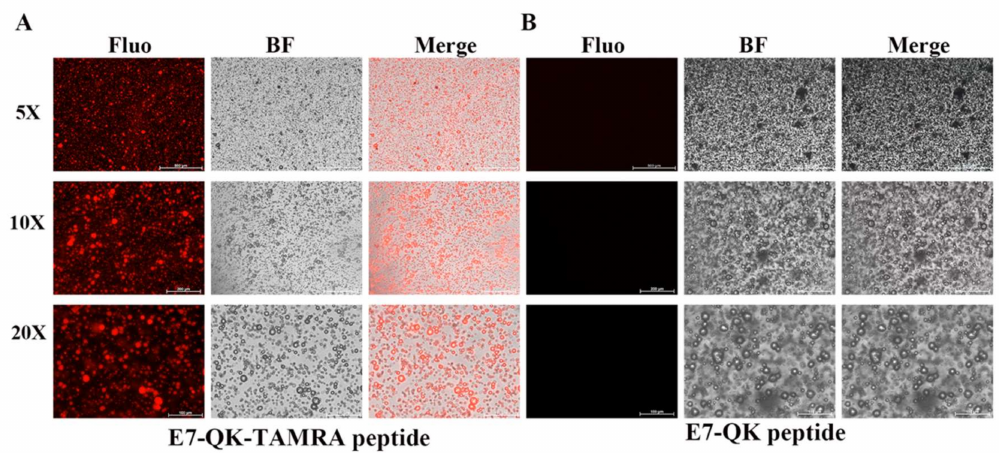
Figure 6. Detection of E7-QK and E7-QK-TAMRA peptide within coll/HA composites by fluorescence microscopy. E7- QK-TAMRA and E7-QK peptide bound to hydroxyapatite was incorporated into coll/HA composite scaffolds. Fluores- cence images were captured with an Axio Observer Z1 fluorescence microscope, using a 5 × (scale bar = 500 µ m), 10 × (scale bar = 200 µ m), and 20 × magnification (scale bar = 100 µ m). ( A ) E7-QK-TAMRA peptide showed to be homoge- neously distributed (red dots) within the coll/HA composites, whereas ( B ) Unlabeled E7-QK peptide was not visible within the